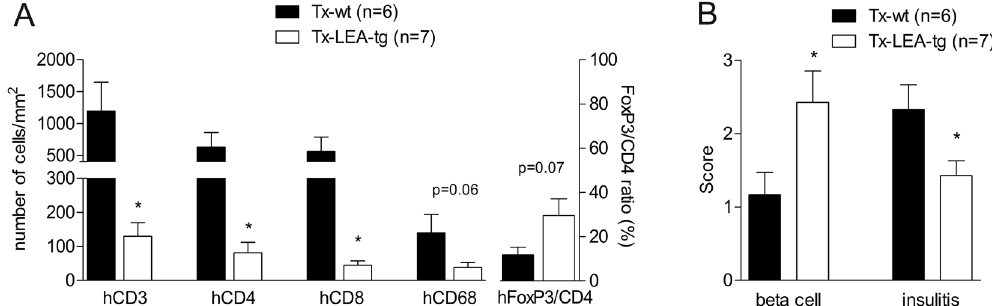
Figure 4. Histological scoring of NPICC grafts and quantification of immune cell infiltration. ( A ) The beta cell insulin score was significantly higher in Tx-LEA-tg as compared to Tx-wt, whereas the insulitis score and the number of infiltrating hCD3 + , hCD4 + , and hCD8 + T cells was significantly lower in these animals (p < 0.05) ( A ). There was a non-significant trend towards a higher frequency of hCD68 + macrophages and a lower FoxP3 + /CD4 + ratio in animals transplanted with wt NPICCs. N = number of animals examined per group. * p < 0.05 Tx-LEA-tg vs.